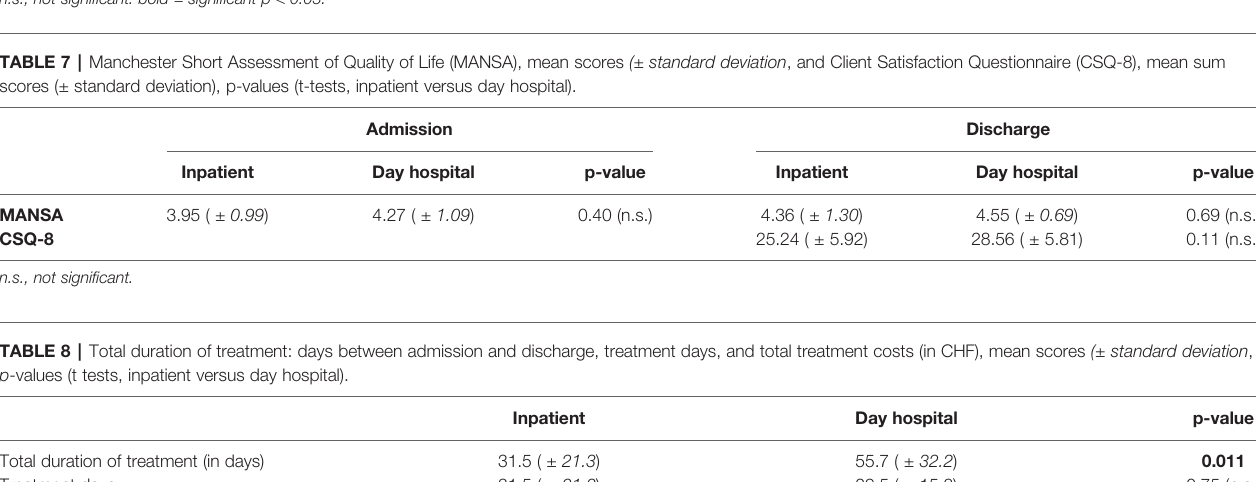
Total duration of treatment (in